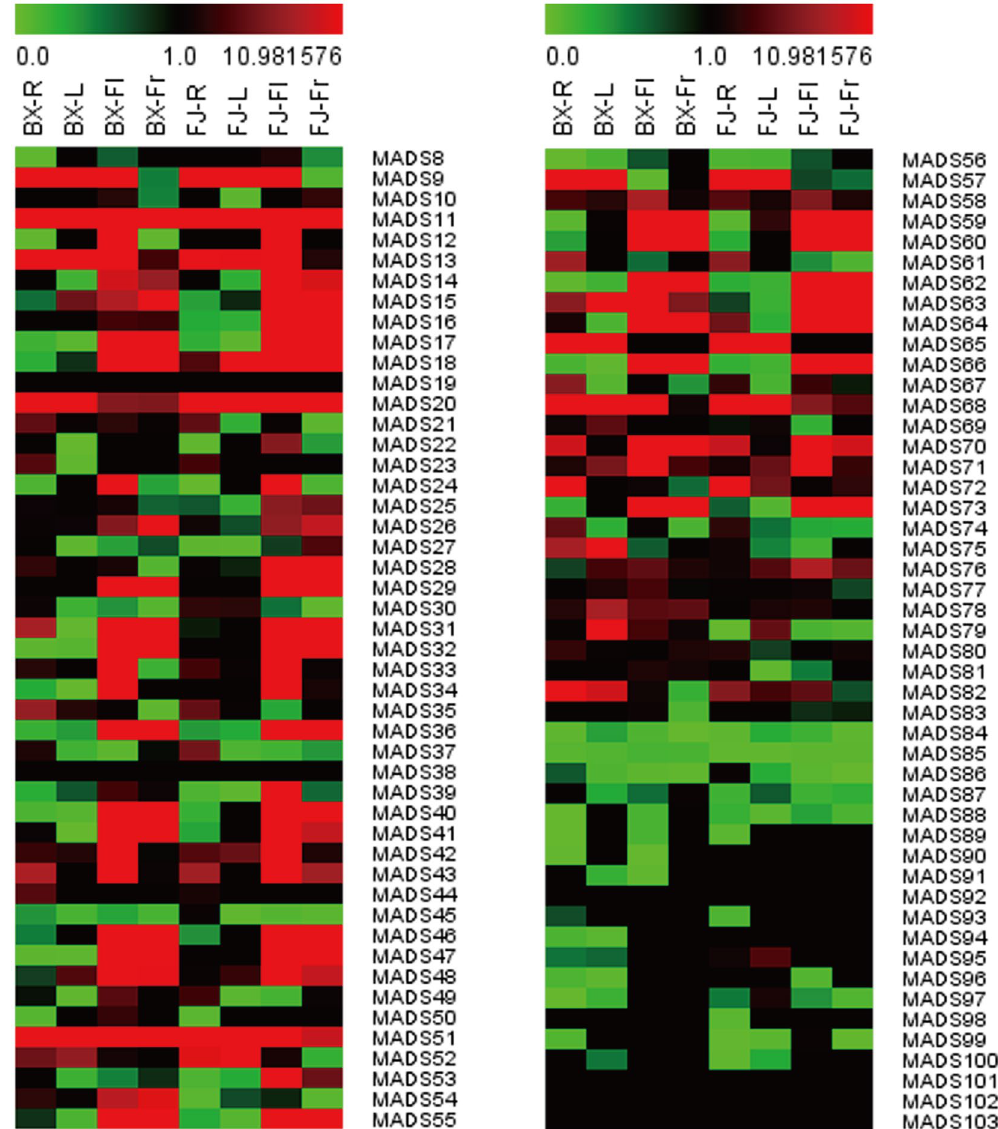
Figure 4. Expression patterns of MaMADSes in the roots (R), leaves (L), flowers (Fl) and fruits (Fr) of BX and FJ. The heat map with clustering was created based on the FPKM value of MaMADSes . Differences in gene expression changes are shown in color as the